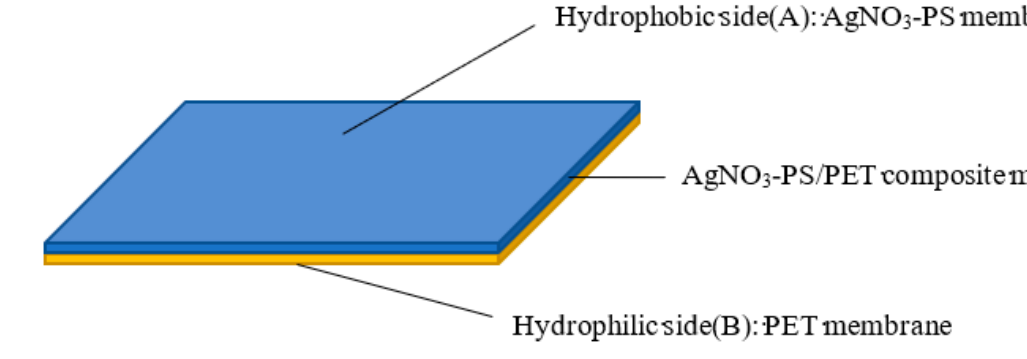
Figure 2. Structural map of AgNO 3 -PS/PET composite membrane.